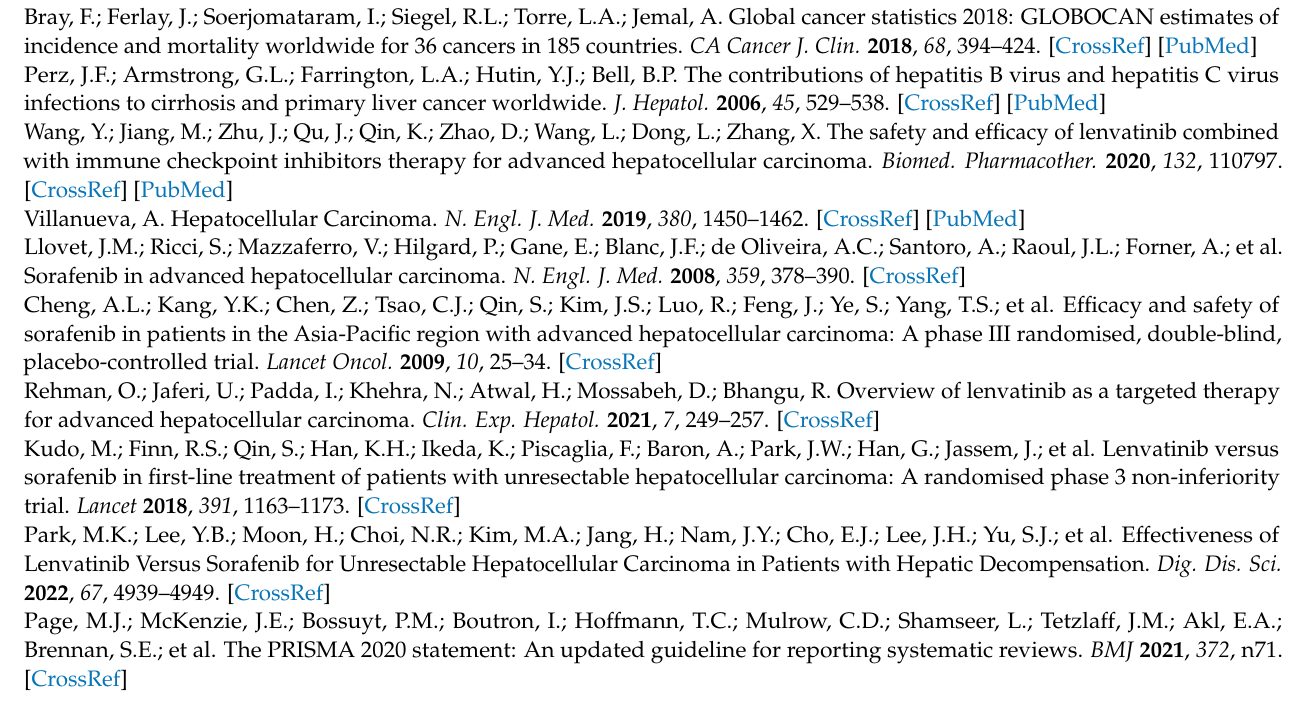
(B) after deleting the limited Western and multicenter studies. Figure S2: The 1-year OS rate (A) and 1-year PFS rate (B) after deleting the limited Western and multicenter studies. Figure S3: The ORR (A) and DCR (B) after deleting the limited Western and multicenter studies. Supplementary Figure S4: Forest plots of the 10 most reported adverse events associated with lenvatinib vs. sorafenib (A, hypertension; B, diarrhea; C, decreased appetite; D, palmar–plantar erythrodysaesthesia; E, fatigue; F, proteinuria; G, rash; H, hypothyroidism; I, elevated aspartate aminotransferase; J, decreased platelet count). Figure S5: The median OS (A) and median PFS (B) for patients not meeting the REFLECT criteria. Figure S6: The 1-year OS rate (A) and 1-year PFS rate (B) for patients not meeting the REFLECT criteria. Figure S7: The ORR (A) and DCR (B) for patients not meeting the REFLECT criteria. Figure S8: The median OS (A) and median PFS (B) for patients with similar study background. Figure S9: The 1-year OS rate (A) and 1-year PFS rate (B) for patients with similar study background. Figure S10: The ORR (A) and DCR (B) for patients with similar study background. Figure S11: Median OS in patients with Child–Pugh class A or B treated with